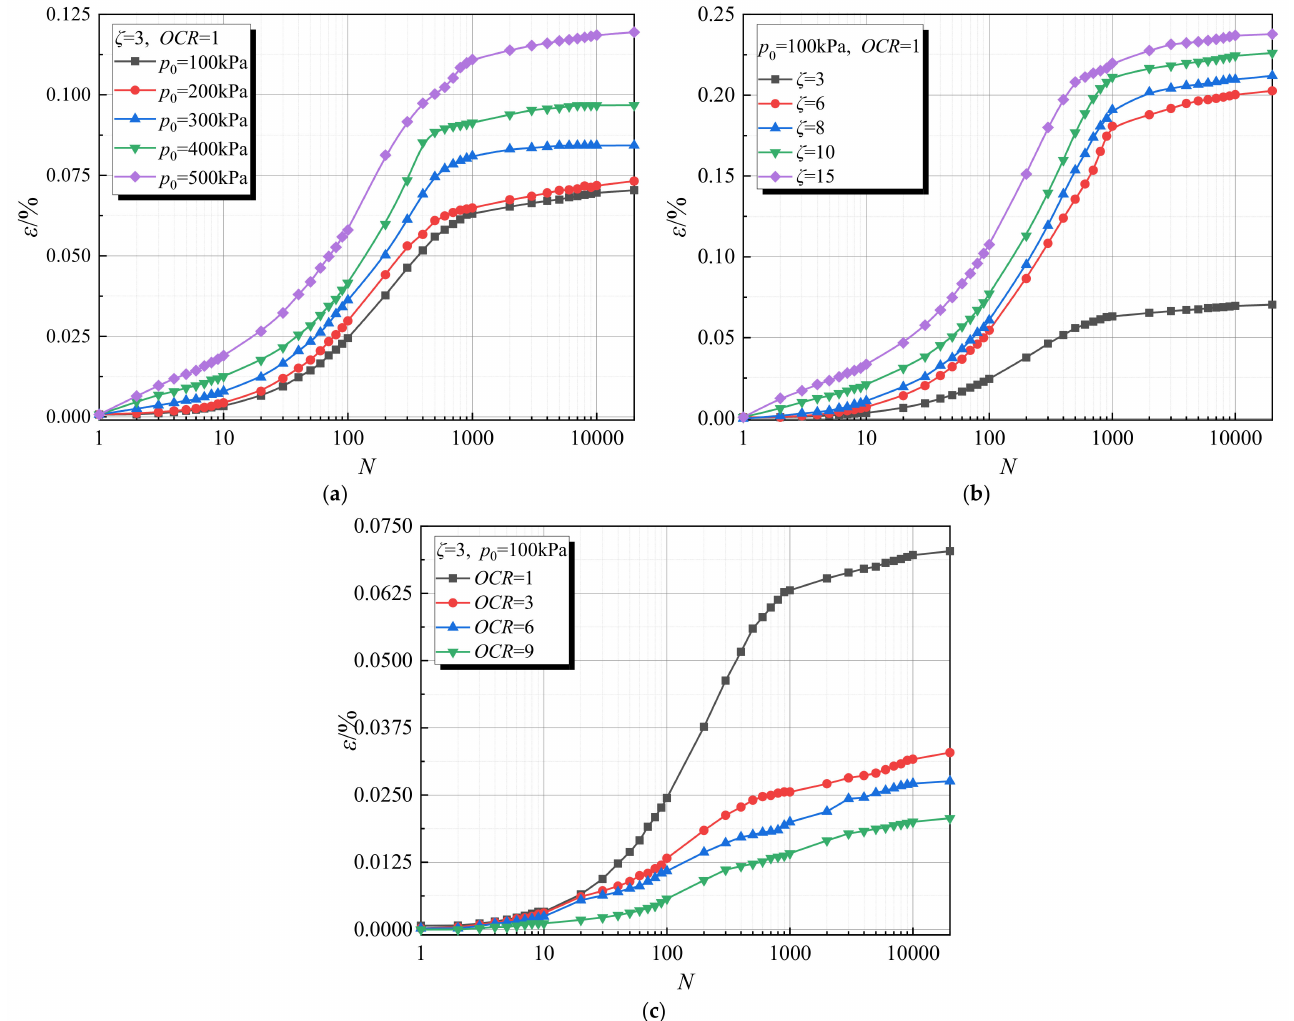
Figure 9. Vibration frequency-accumulated strain diagram under different test conditions: ( a ) SEM-A, ( b ) SEM-B, and ( c )